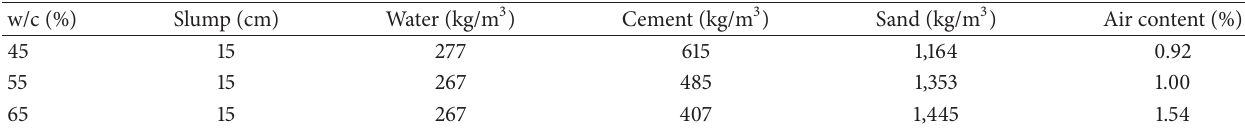
Table 2: Detailed mix